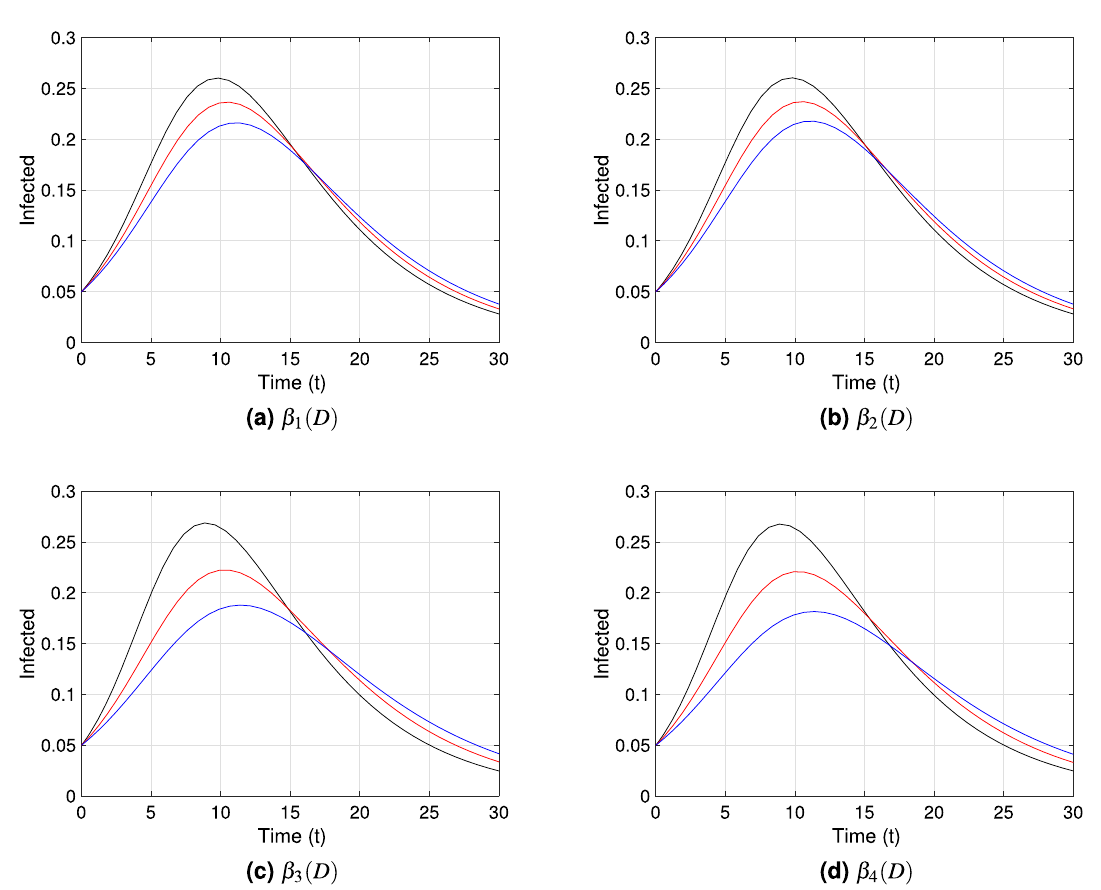
Figure 3. Point prevalence, I ( t )/ N , from the system in Eq. (1) with respect to time for each transmission functional form and ν = 0.5 . Black, red and blue curves correspond to D ∗ = 0.75 ( m ) , D ∗ = 1.05 ( m ) , and D ∗ = 1.35 ( m ) respectively. These correspond to societies of small ([0, 100)), medium ([100, 120]) and large ( [ 120, ∞ ) ) natural-distance types respectively (see Table 1). The other parameter values are fixed at β ∗ = 0.5 ; γ = 0.2 , ν = 0.5 , (cid:31) 1 = 0.03 , (cid:31) 2 = 0.3 . The R 0 value for each society are for ( a ) and ( b ): R 0 = 2.7 (black), R 0 = 2.5 (red), R 0 = 2.3 (blue); ( c ) and ( d ): R 0 = 3.0 (black), R 0 = 2.5 (red), R 0 = 2.2 (blue). The initial condition D ( 0 ) = D ∗ was used for each type of